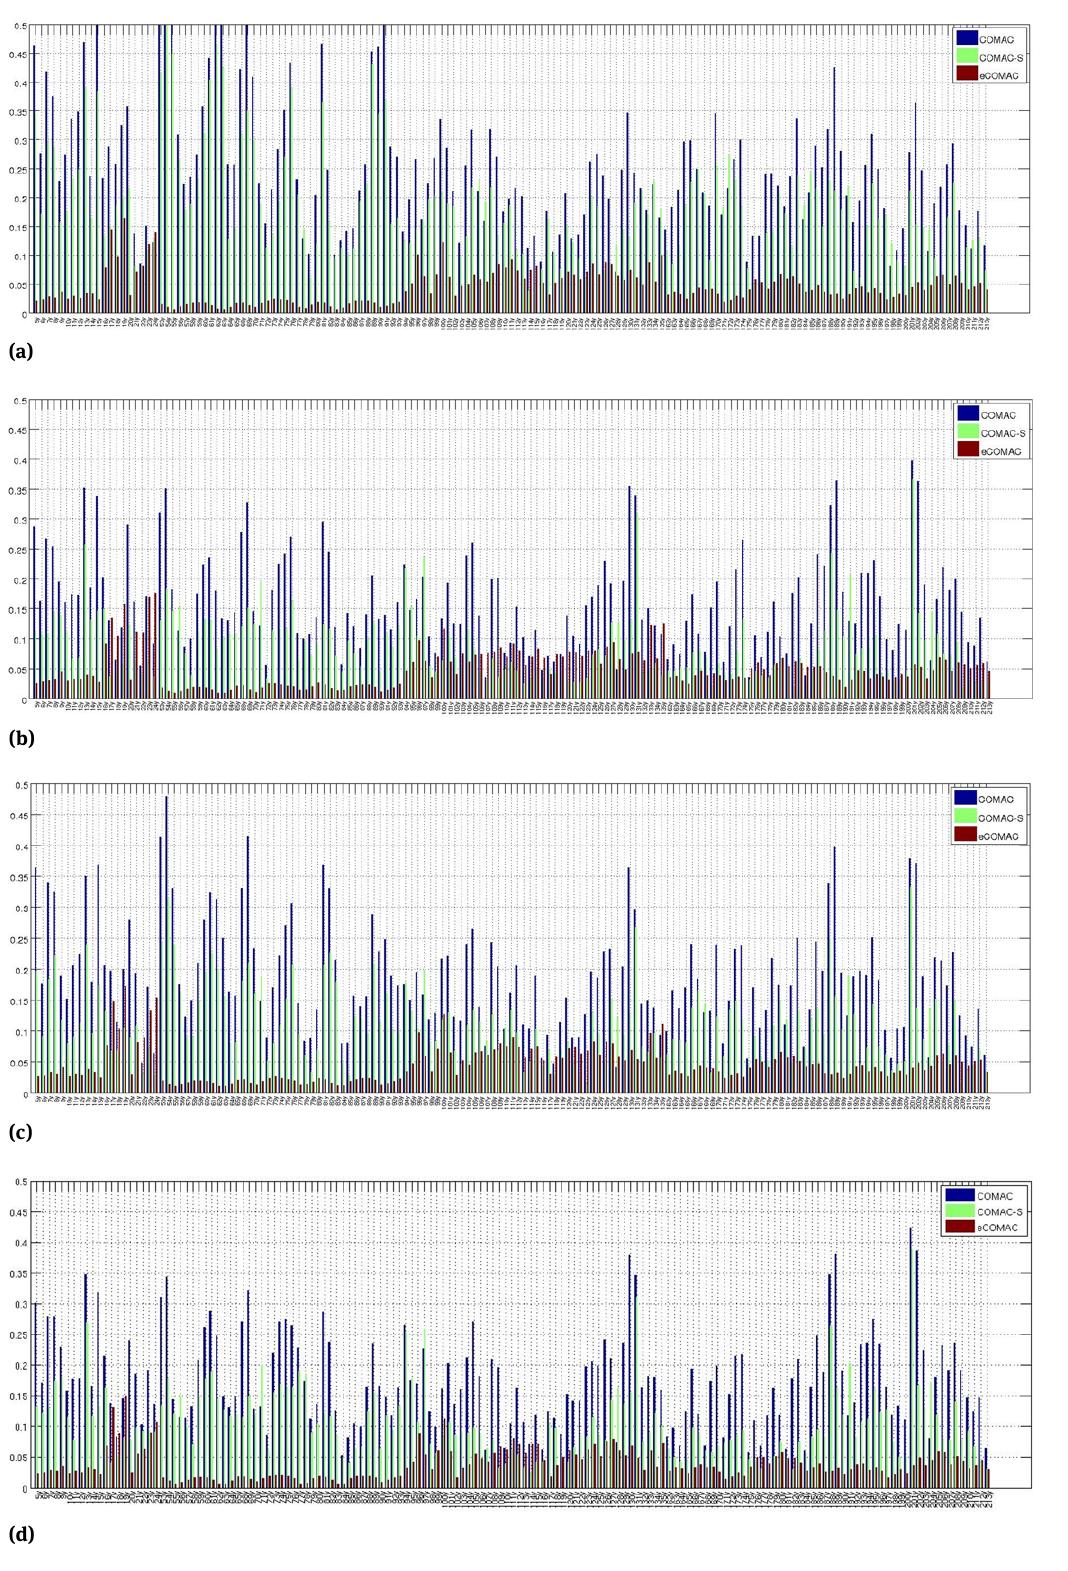
Figure 6: Comparison of COMACs: a) SDtools-Exp (non-updated), b) SDtools-Exp(updated) c) MSC/NASTRAN-Exp (updated), d)